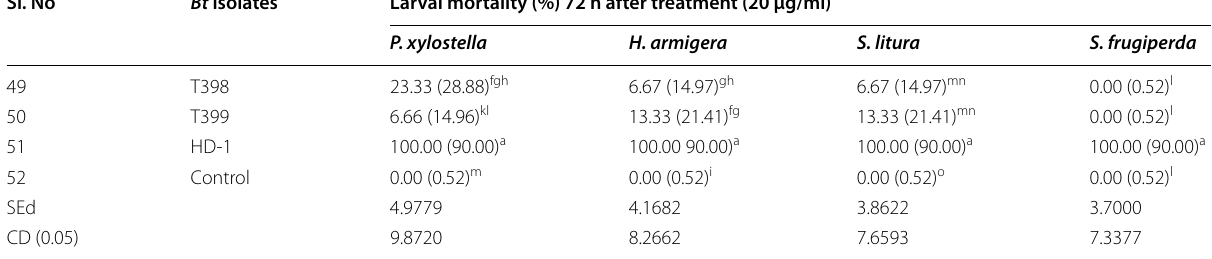
Figures in parentheses are arcsine transformed values of percentages. Values followed by the same letters in a column are not significantly different ( p DMRT